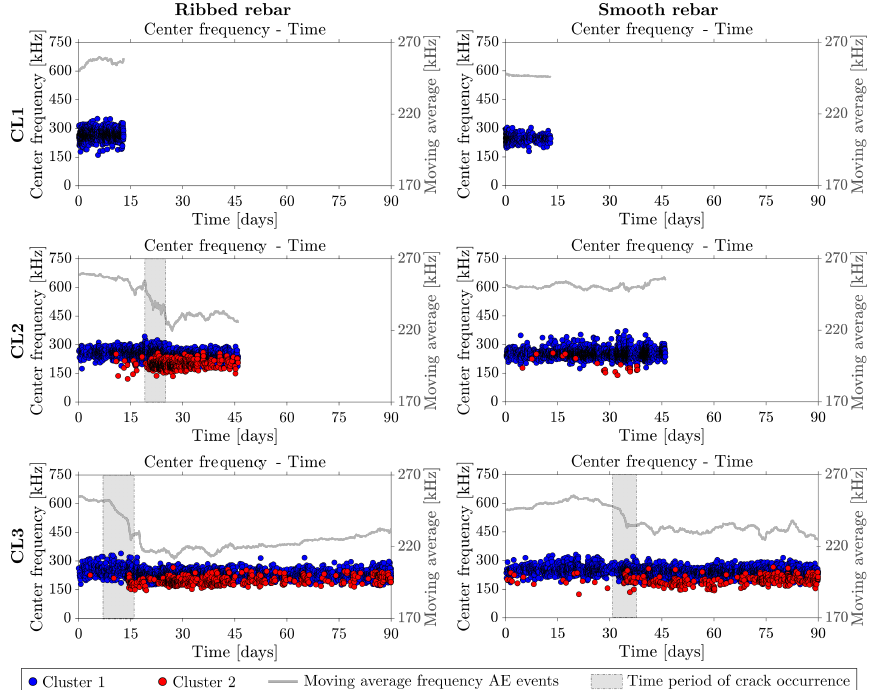
Figure 6. Clustering results for all RC prisms represented as center frequency versus time: ( top left ) CL1-R, ( middle left ) CL2-R, ( bottom left ) CL3-R, ( top right ) CL1-S, ( middle right ) CL2-S, and ( bottom right ) CL3-S. The period in which the surface crack occurred is indicated by the grey